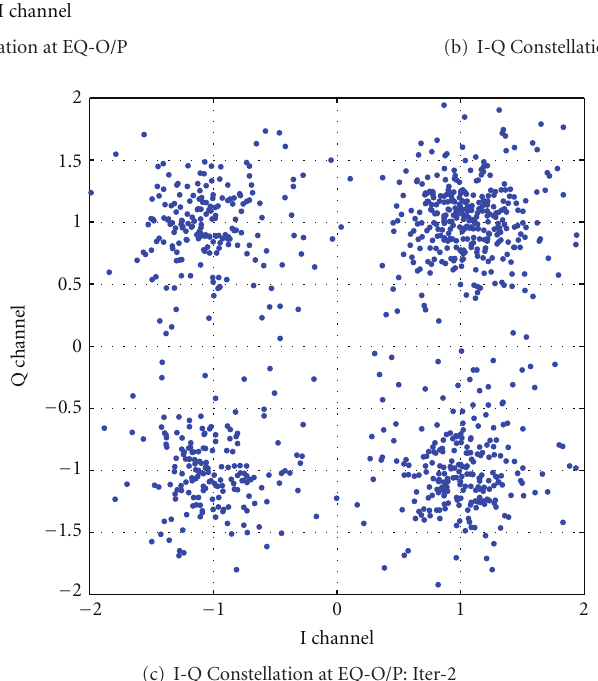
Figure 10: Constellation output from equalizer and iterative